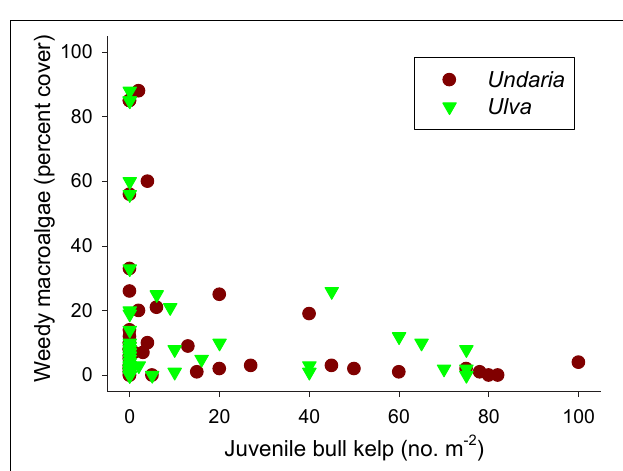
FIGURE 7 | Relationship between cover of weedy macroalgae (the non-native kelp Undaria pinnatifida and green sheet-forming Ulva spp.) and recruit densities of Durvillaea in 48 plots 4 months after a removal experiment was initiated (with 12 undisturbed control plots and 36 plots with different intensities of bull kelp removals, see Figure 6 for